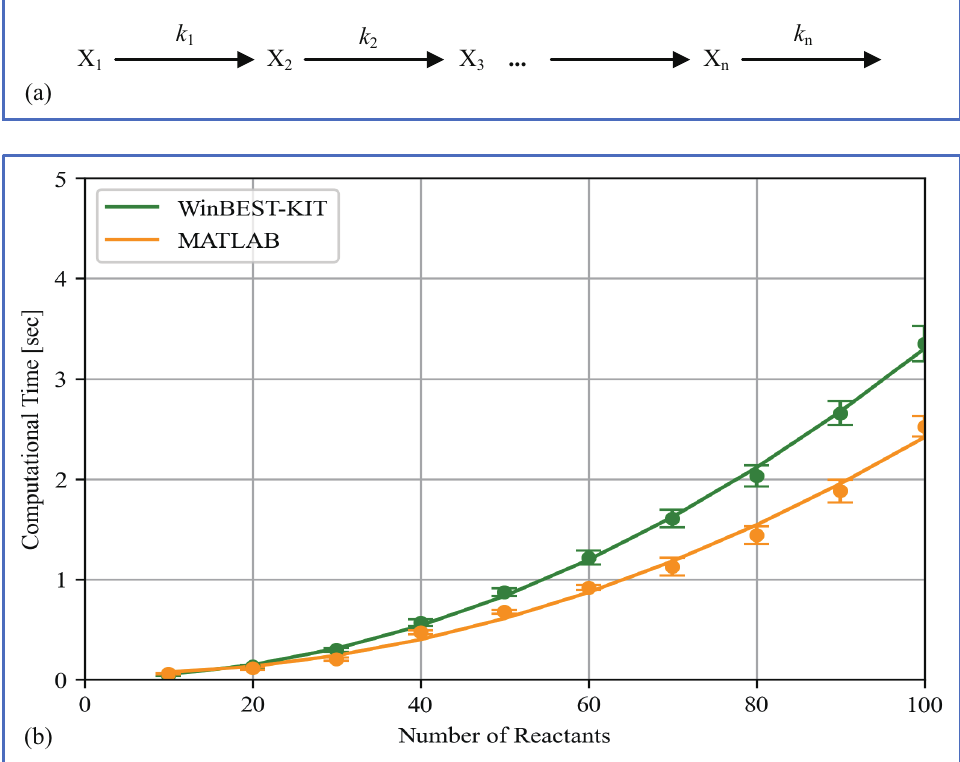
Figure 14. ( a ) System diagram of the linear subsequent reaction system. ( b ) Comparison results of the computational time with respect to the number of reactants. Each measurement point is the mean value of 100 times calculations and the error bar shows its standard